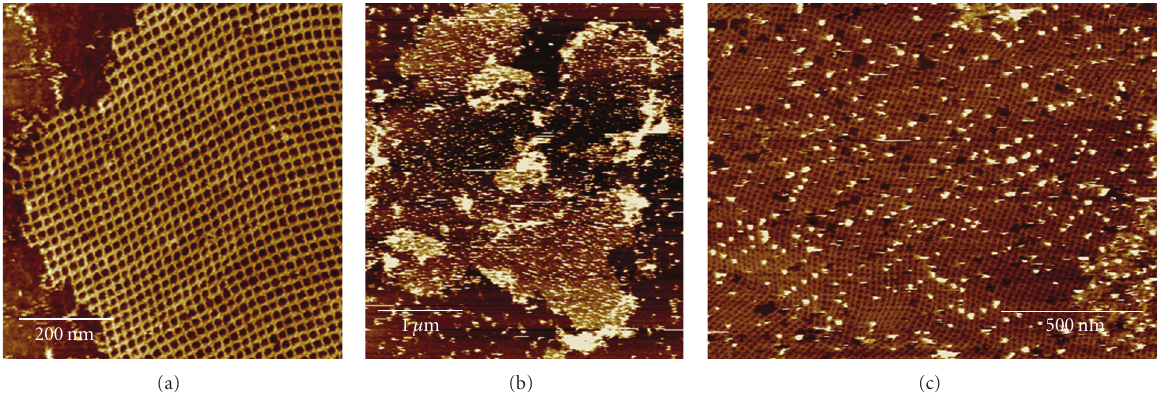
Figure 3: AFM images of a DNA lattice (a) and a DNA lattice incorporating POC isolated from reaction 3 after addition of 5nm gold nanoparticles (b) and (c).